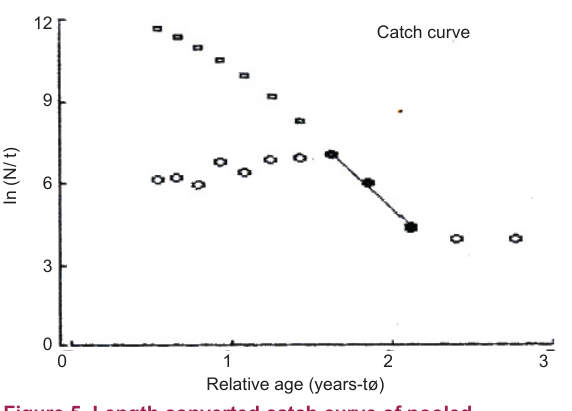
Figure 5. Length converted catch curve of pooled population of Horabagrus brachysoma in River Periyar (Z from catch curve = 5.64; M = 1.04; F = 4.60; E (F/Z) =